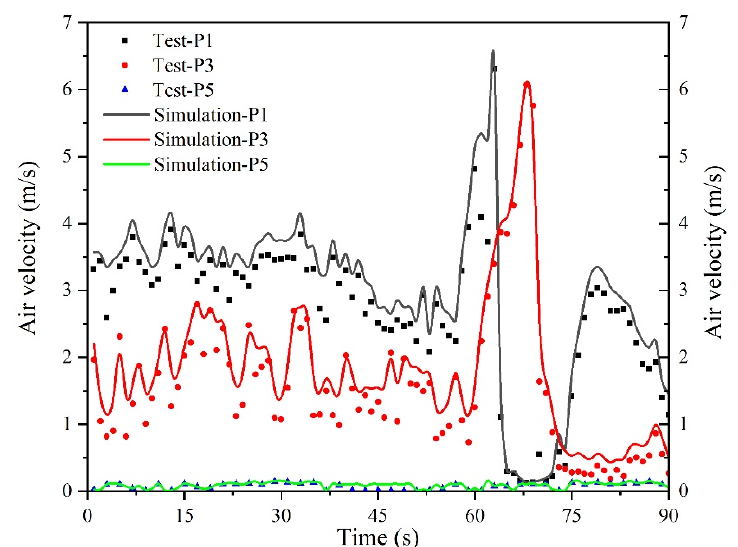
Figure 6. Comparison of air velocity between field tests and simulation results.